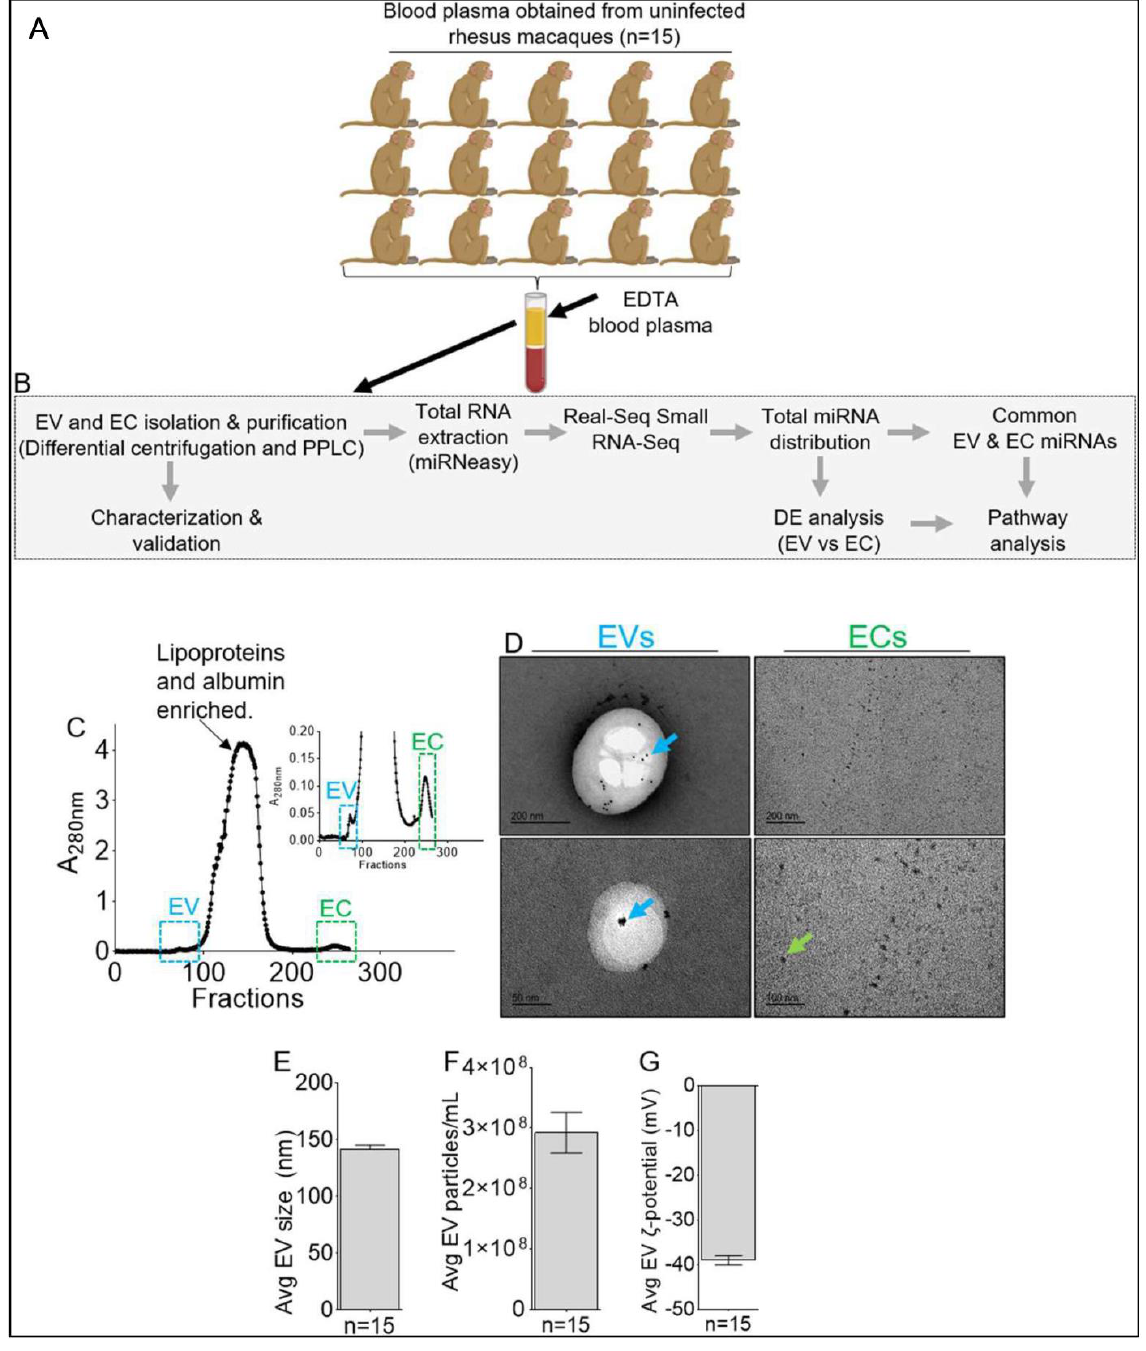
Figure 1. Study workflow, EV and EC isolation and characterization. ( A ) Description of experimental model; 15 male Indian Rhesus Macaques were randomly assigned to 5 groups of 3. Pre-infection and pre-treatment blood plasma samples were collected and processed. ( B ) Methodological workflow for isolation of EVs and ECs and their characterization. ( C ) Representative PPLC spectra of EVs and ECs. Blue box: indicates EV-containing fraction. Green box: indicates EC-containing fraction. ( D ) Representative negative-stain TEM images of purified EVs and ECs from pooled ( n = 15) RMs. Blue arrows indicate gold-labeled CD9 on the surface of EVs. Green arrows indicate ECs. Scale bars: 200 nm for EVs and ECs (Top), 50 nm EVs (bottom), and 100 nm ECs (bottom). ( E – G ) Nanoparti‑ cle tracking analysis (NTA) measurements of different BEV properties, including ( E ) mean EV size, ( F ) mean EV concentration, ( G ) mean EV